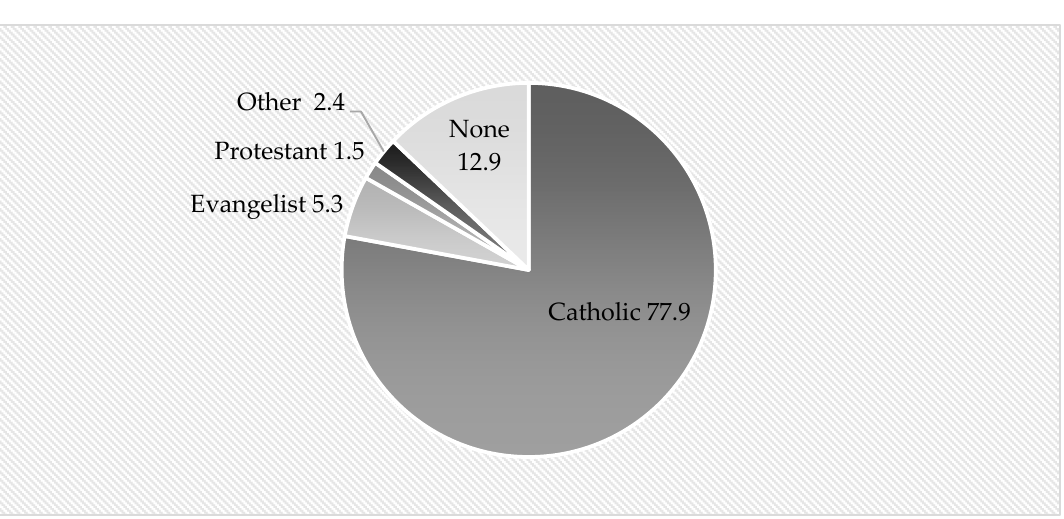
Figure 1. Religious self-adscription of Latin American immigrants (percentage).